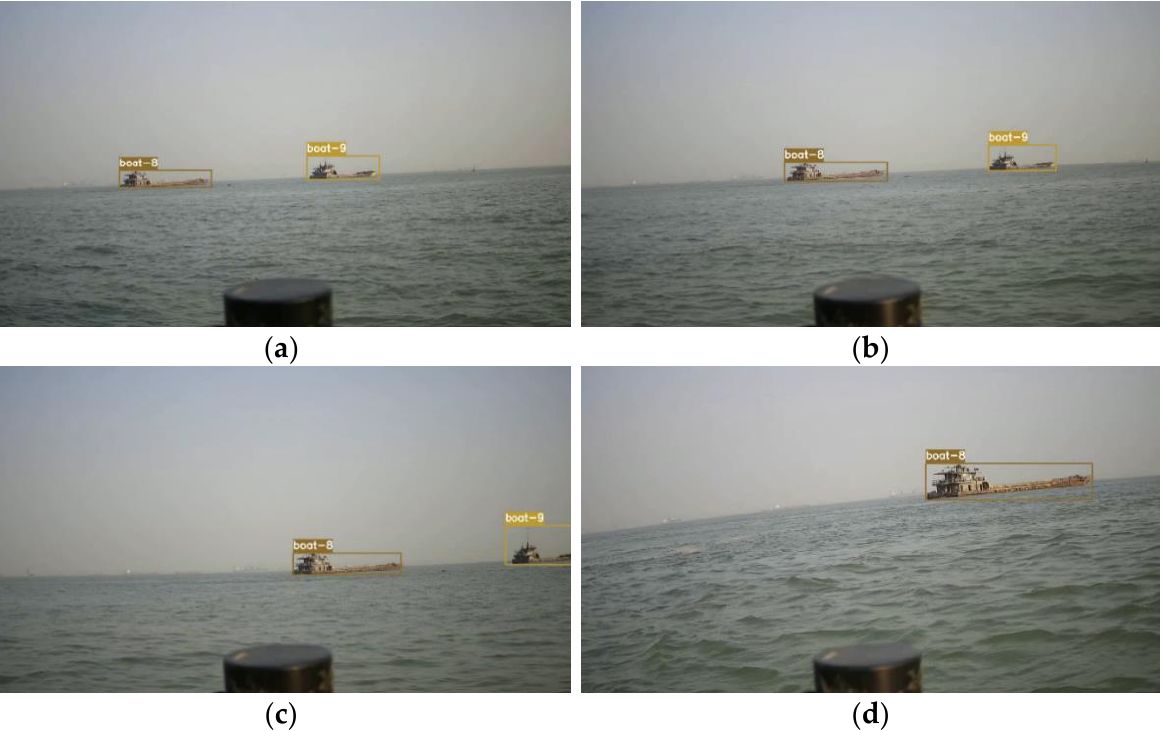
Figure 16. Target detection and tracking result 2 of improved YOLOv4 and UKF algorithm. ( a ) Screenshot at frame 73. ( b ) Screenshot at frame 254. ( c ) Screenshot at frame 448. ( d ) Screenshot at frame 624.